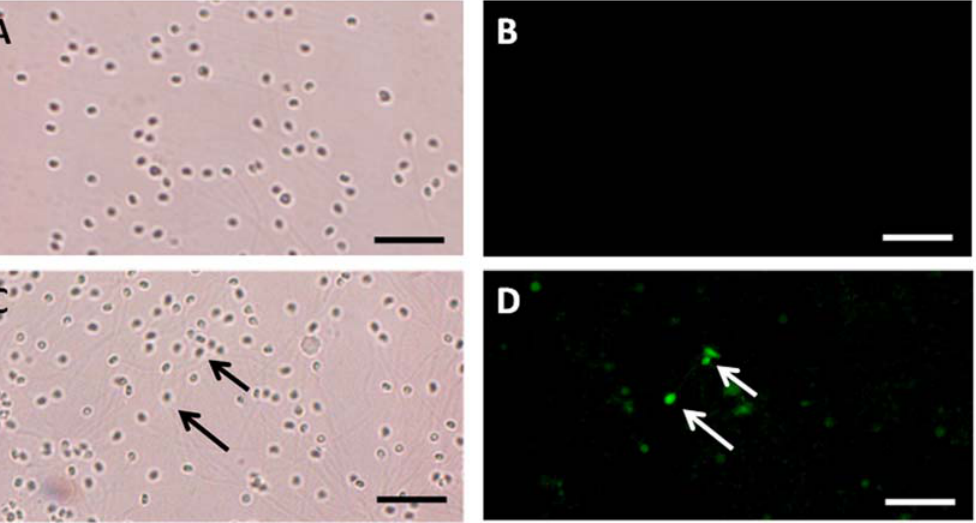
Figure 3. Visualization of donor-derived spermatozoa in sperm collected from surrogate fathers 10 months after transplantation. A) Bright field view of non-transplanted control spermatozoa. B) Corresponding view of A) under fluorescent light. C) Bright field view of sperm from a surrogate father. D) Corresponding view of C) under fluorescent light showing fluorescent (CFDA-SE-labeled) donor-derived cells (arrows). Scale bars indicate 20 m